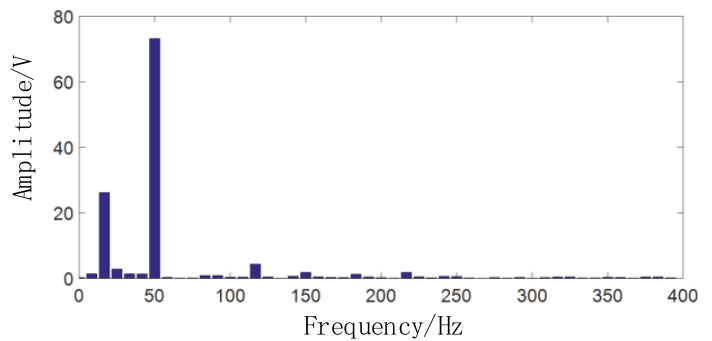
Figure 4. Simulink simulation of the CVT secondary side waveform. It can be observed from the time-domain waveform that the secondary voltage is clearly distorted. The FFT analysis function in Powergui is used to perform a frequency- domain analysis of the waveform, and the frequency spectrum is shown in Figure 5.